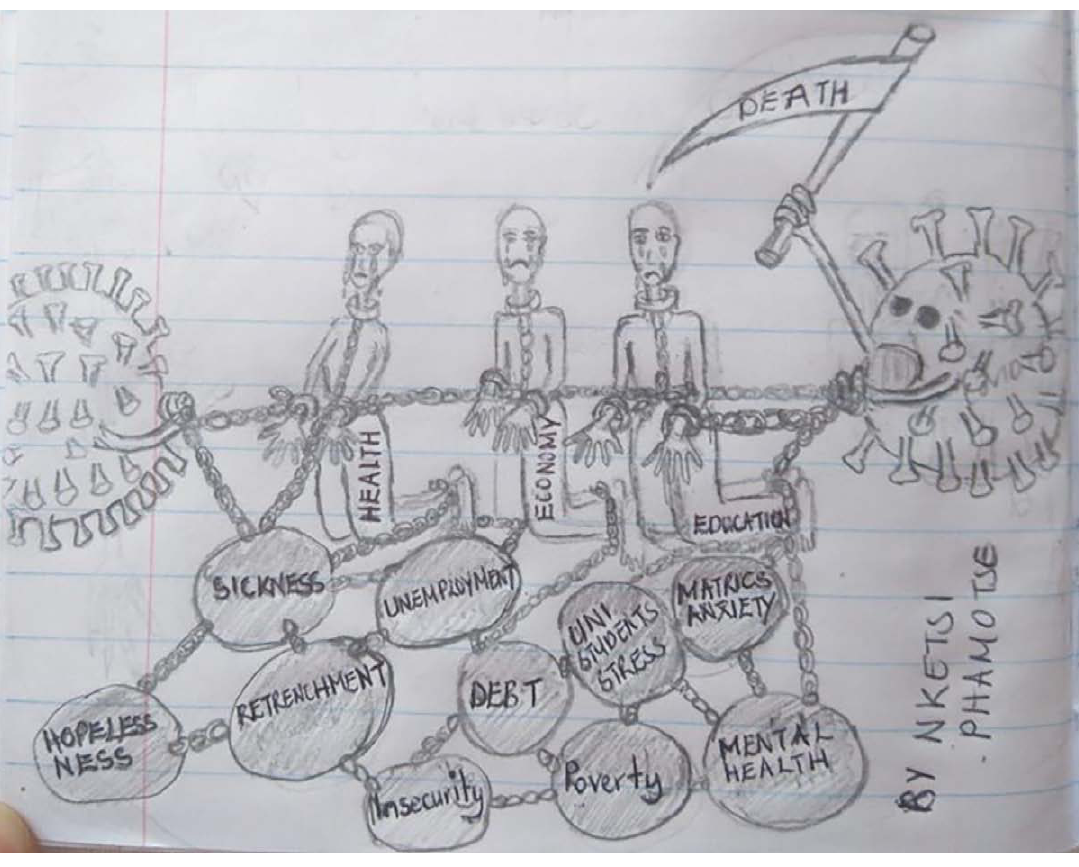
Figure 3. ‘Untitled’ by Nketsi